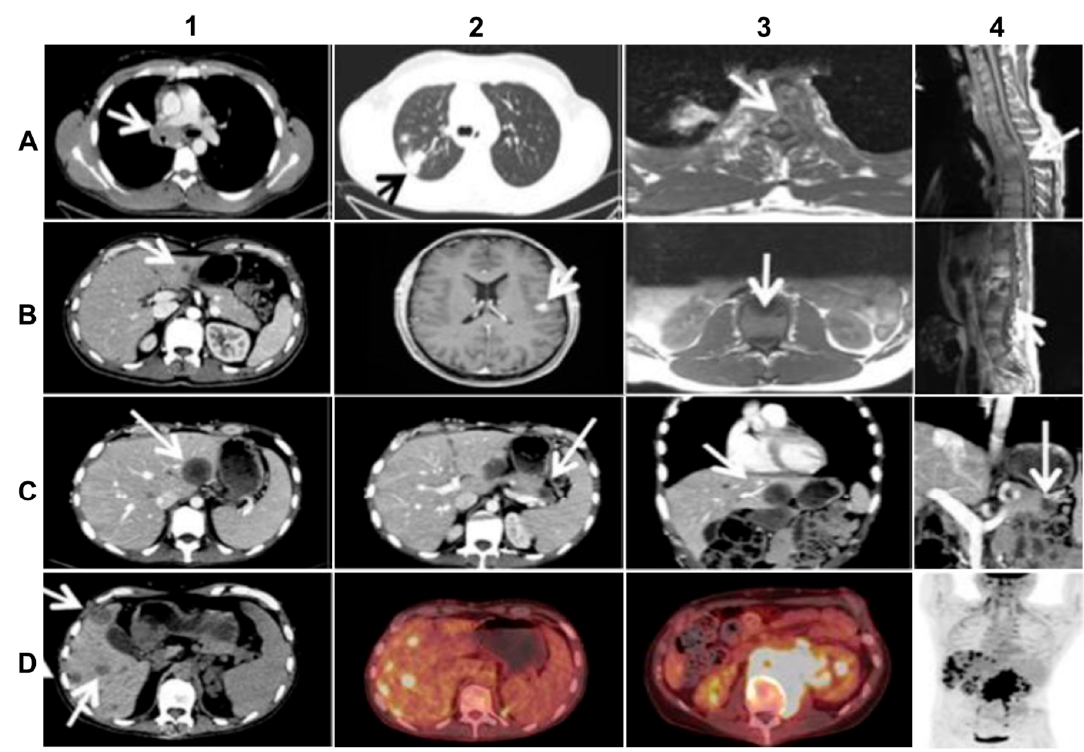
Figure 2. Imaging of the advanced (stage IV) ALK -rearranged NSCLC at diagnosis and at relapse after sequential treatment with Crizotinib, Alectinib, and re-challenge with Alectinib ( relevant changes indicated by arrows ). ( A ) top line from left to right: diagnostic CT (A1,A2) and MR (A3,A4) scans at baseline showing metastasized mediastinal lymph nodes compressing the vena cava superior (A1), the primary lung tumor in the right upper lobe (A2), transversal (A3) and sagittal (A4) images of vertebral metastases with spinal cord affection; ( B ) second line from left to right: CT (B1,B2) and MR (B3,B4) scans at progression after 10 months of Crizotinib treatment, showing liver metastasis (B1), the largest brain metastasis (B2), transversal (B3) and sagittal (B4) images of new vertebral metastases affecting the spinal cord; ( C ) third line from left to right: CT scans (C1–4) after 3 months of Alectinib treatment, exhibiting mixed response including new hepatic (C1,C3) and pancreatic (C2,C4) metastases on transversal and frontal planes; ( D ) last line from left to right: CT-(D1), PET/CT- (D2, D3), and upper part of total-body PET-scan (D4) at progression after re-challenge with Alectinib, showing multiple new hepatic metastases (D1,D2,D4) and a large retroperitoneal conglomerate of metastasized lymph nodes involving the left kidney (D3, D4).